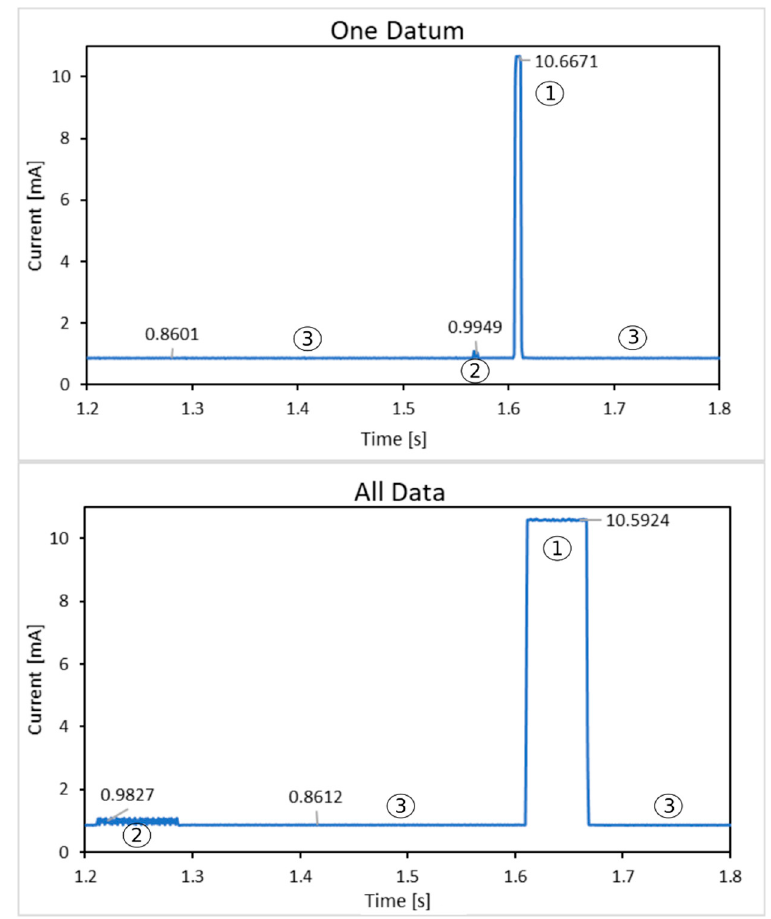
Figure 8. Current draw by the tag in the transmission scenario at 4.2 V in the supercapacitor. The upper graphic shows the transmission of one datum and the lower graphic the transmission of all data. The numbers represent which element is the one that has the largest contribution to the consumption of the tag in that interval in each case: 1 is for the transceiver, 2 is for the EEPROM and 3 is for the microcontroller. There is a value per number to represent the average consumption of each zone in the two graphics.